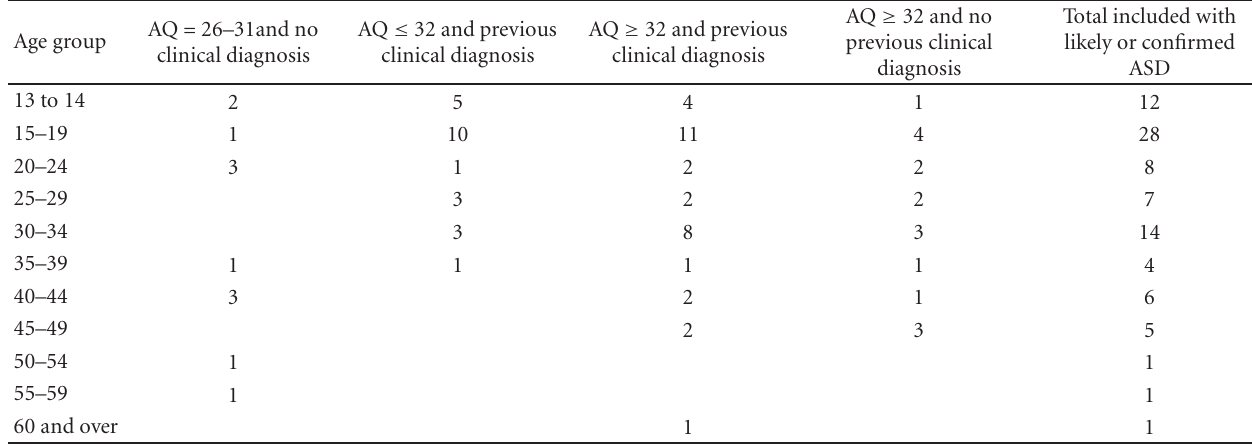
Table 4: Distribution of males with possible or definite diagnosis of HFPDD by